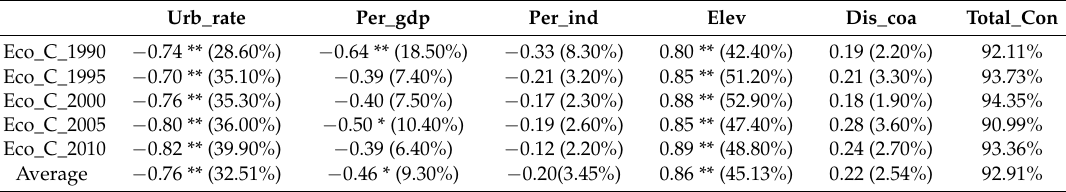
Table 3. The correlation coefficients (r) among EI and its influencing factors during 1990–2010. The proportion of the EI variance explained by the influencing factors with LMG metric was also illustrated in